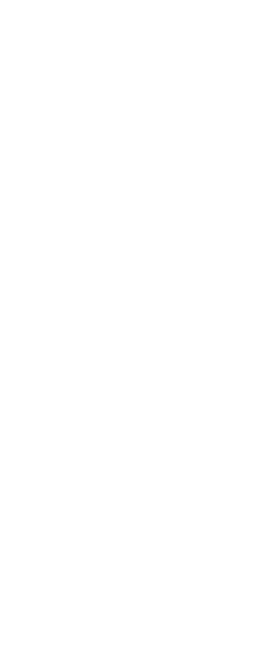
Predicted number of inflations when maximum pressure is 40 mmHg